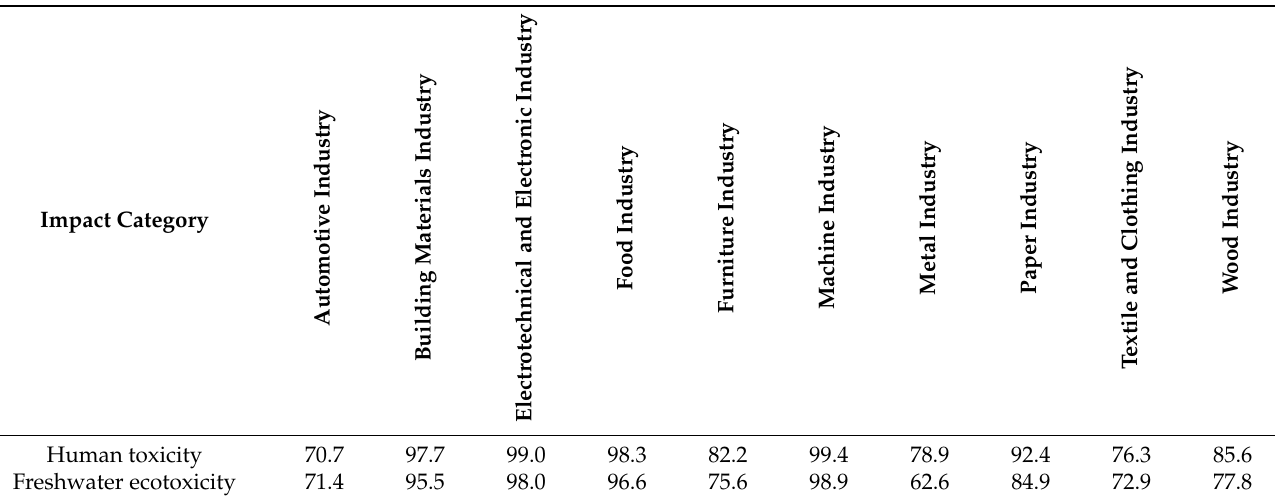
Figure 4. Eco-efficiency of manufacturing in Poland (DMU 1—automotive industry; DMU 2—building materials industry; DMU 3—chemical industry; DMU 4—electrotechnical and electronic industry; DMU 5—food industry; DMU 6—furniture industry; DMU 7—machine industry; DMU 8—metal industry; DMU 9—paper industry; DMU 10—textile and clothing industry; DMU 11—wood industry). Table 3. Percentage potential reductions in environmental